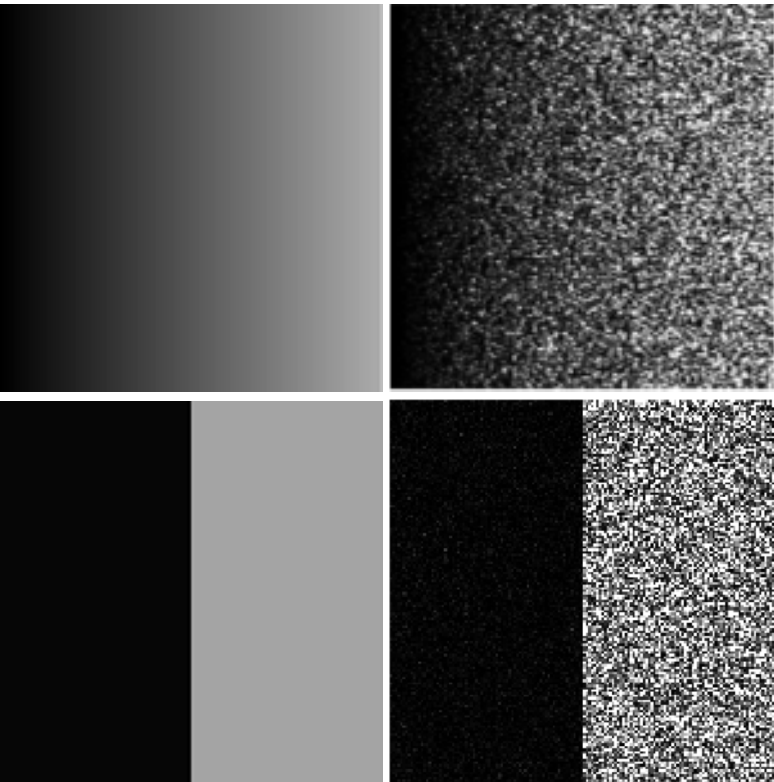
Figure 5. Simulated data used in the Monte Carlo experiments: ( top ) degraded data and step data ( bottom ). Bitmap are shown on the left column and simulated samples are shown on the right column. All filters were tuned to the designs recommended by their authors, only with slight modifications (mask size and threshold) for PPB and FANS that yielded improved mean and ENL